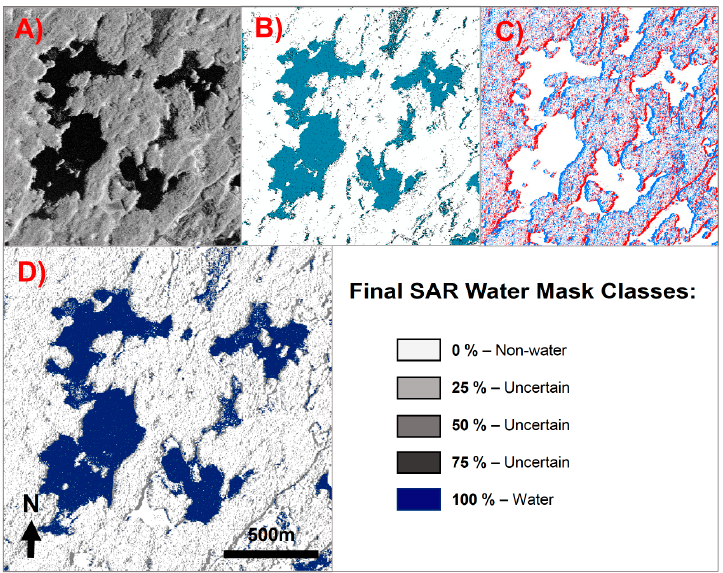
Figure 3. Example of masks created using TSX data for 2 April 2016: ( A ) Processed SAR intensity image, greyscale with black representing low intensity values ( − 25 dB) and white representing high intensity values (0 dB); ( B ) SAR threshold water mask showing three classes—water (blue), uncertain (black), and non-water (white); ( C ) Error mask showing three classes; shadow commission zones in blue, layover omission zones in red, and no error in white; and ( D ) Final SAR water mask showing five classes representing the probability that a pixel is water.